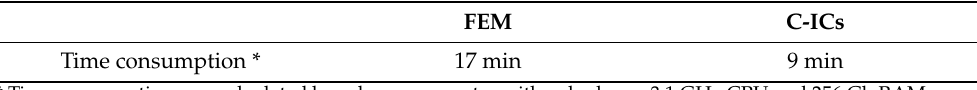
Table 3. Comparison of time consumption.